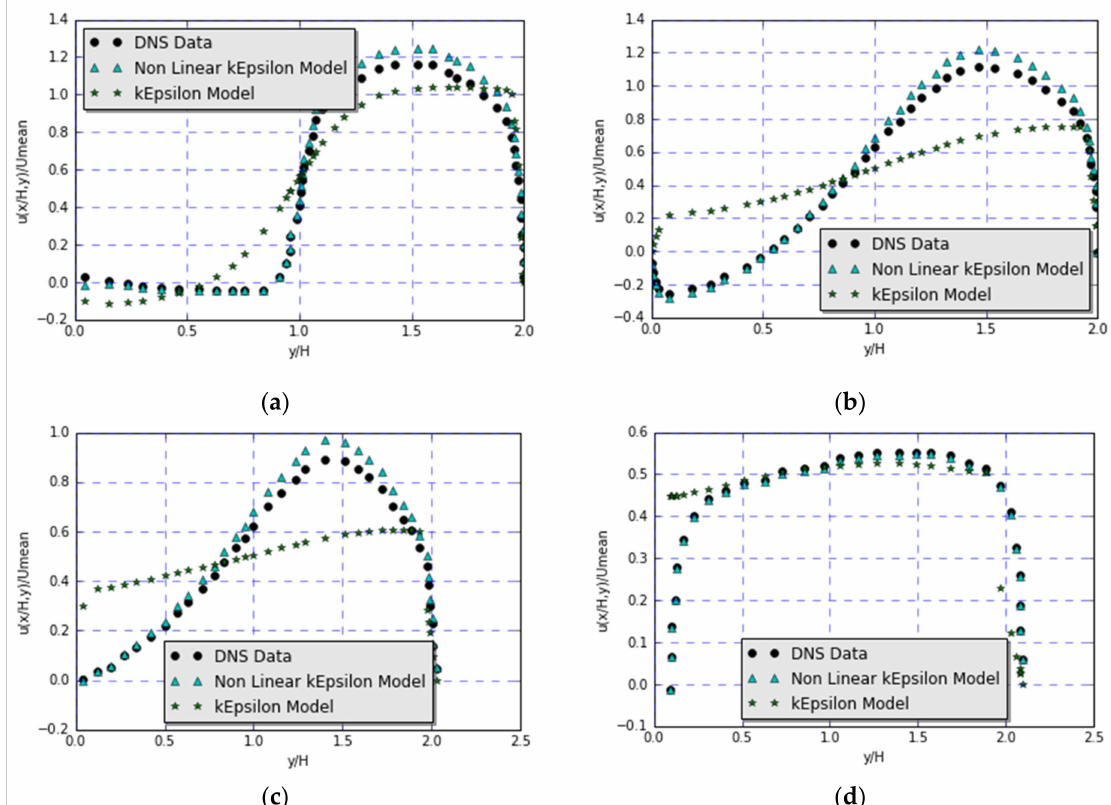
Figure 6. Comparison of different turbulence models: ( a ) DNS simulations; ( b ) RANS standard k − (cid:101) model and the optimized nonlinear RANS turbulence k − (cid:101) model for Re = 9000 ( a ) x / H = 0.5; ( b ) x / H = 4.0; ( c ) x / H = 8.0; ( d ) x / H = 20.0.